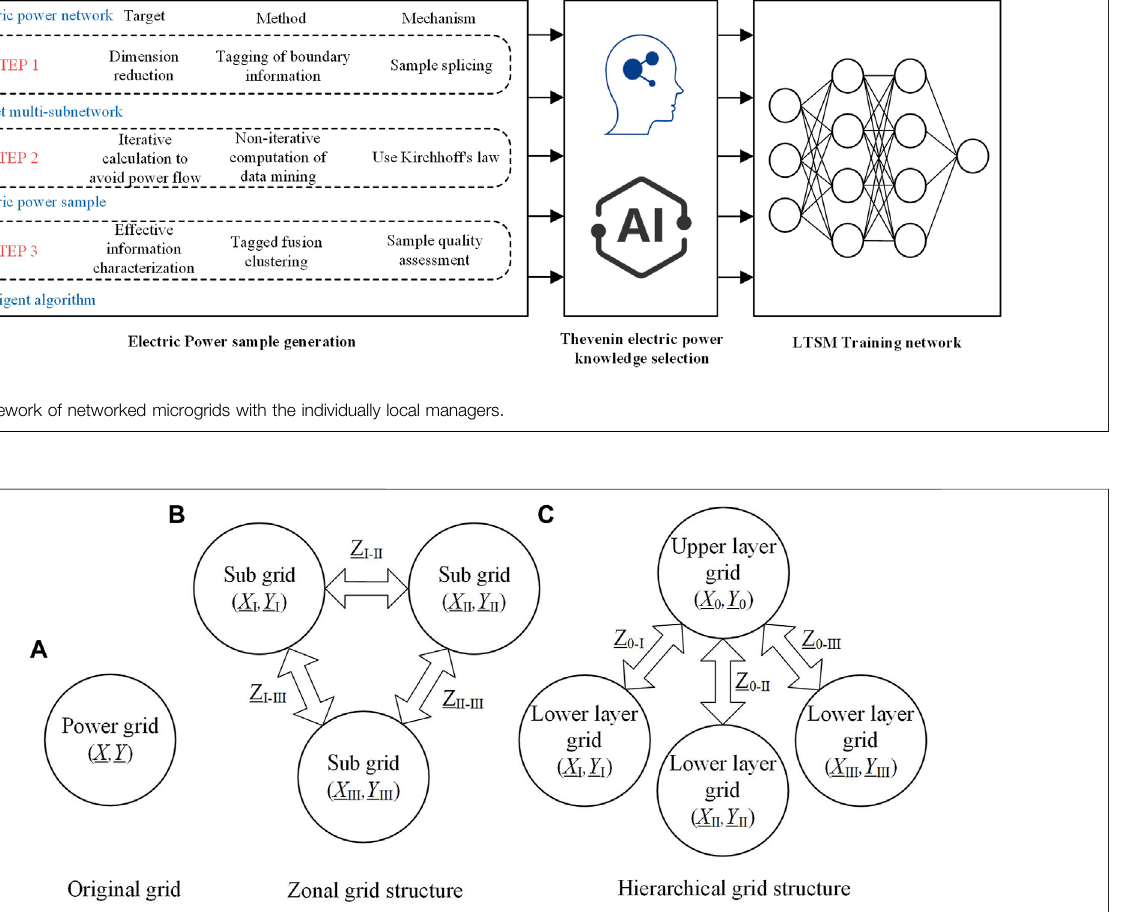
Frontiers in Energy Research |